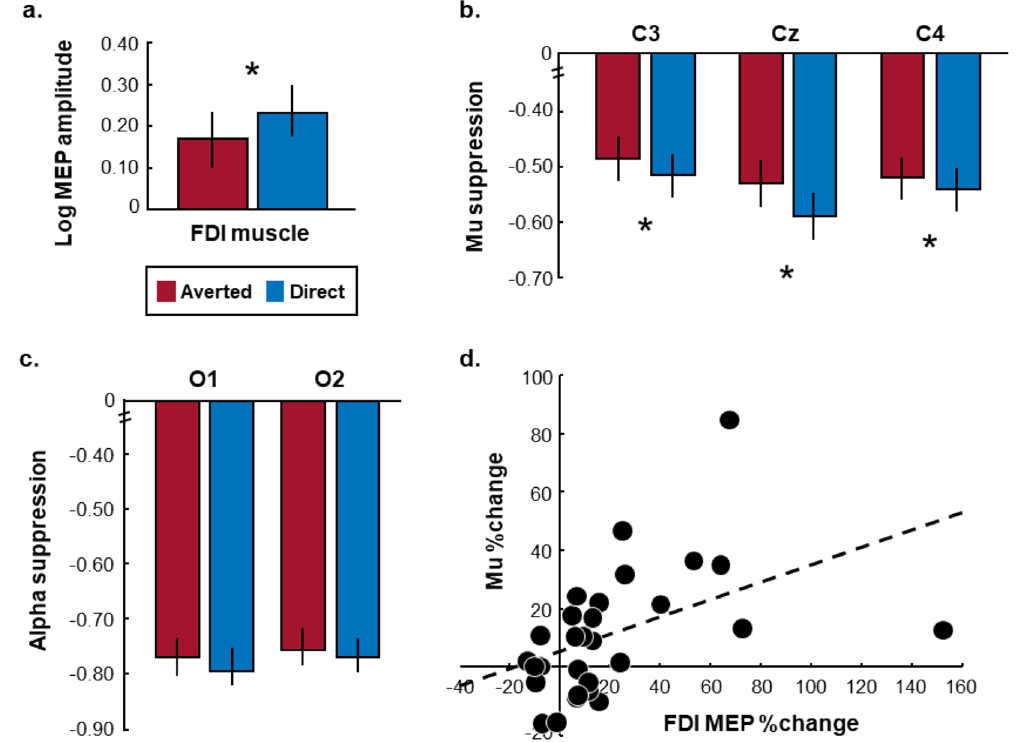
Figure 2. MEP and mu/alpha suppression results. ( a ) Significant effect of perceived eye gaze (direct, averted) on log-transformed MEP peak-to-peak amplitude scores recorded from the FDI muscle ( b ) and mu suppression indices per central electrode . * p < .05, vertical error bars denote mean ± SE. ( c ) The effect of perceived eye gaze on alpha suppression over occipital electrodes was not significant. ( d ) A significant positive correlation was found between condition-specific (i.e. eye contact related) changes in MEP amplitude and EEG mu suppression (averaged across central electrodes).